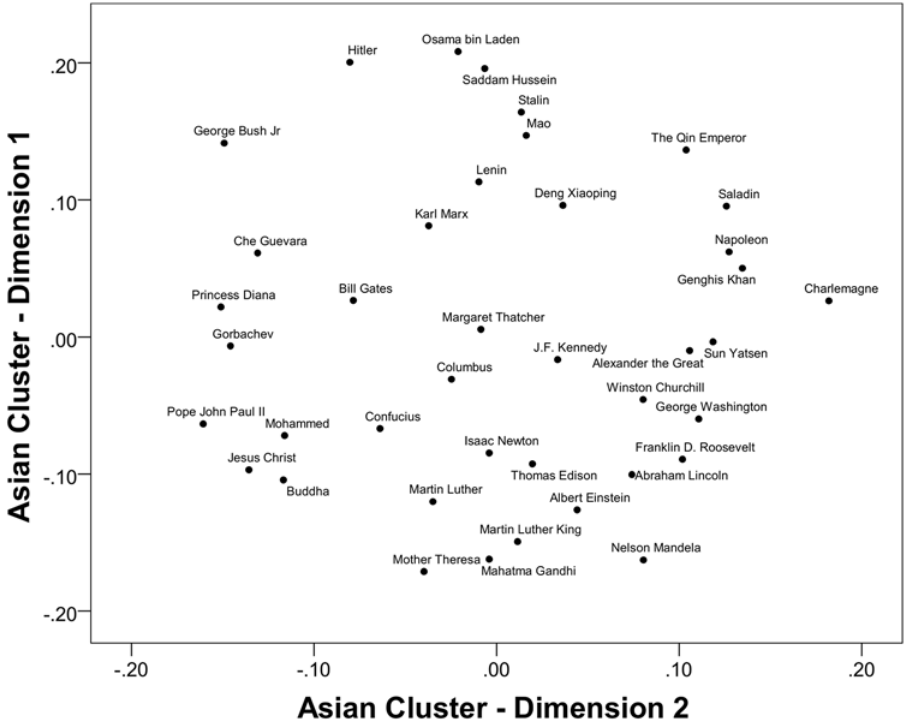
Fig 5. Rotated MDS solution for the Asian (China, Hong Kong, India, Japan, Singapore, South Korea, Taiwan) cluster with all 40 figures.